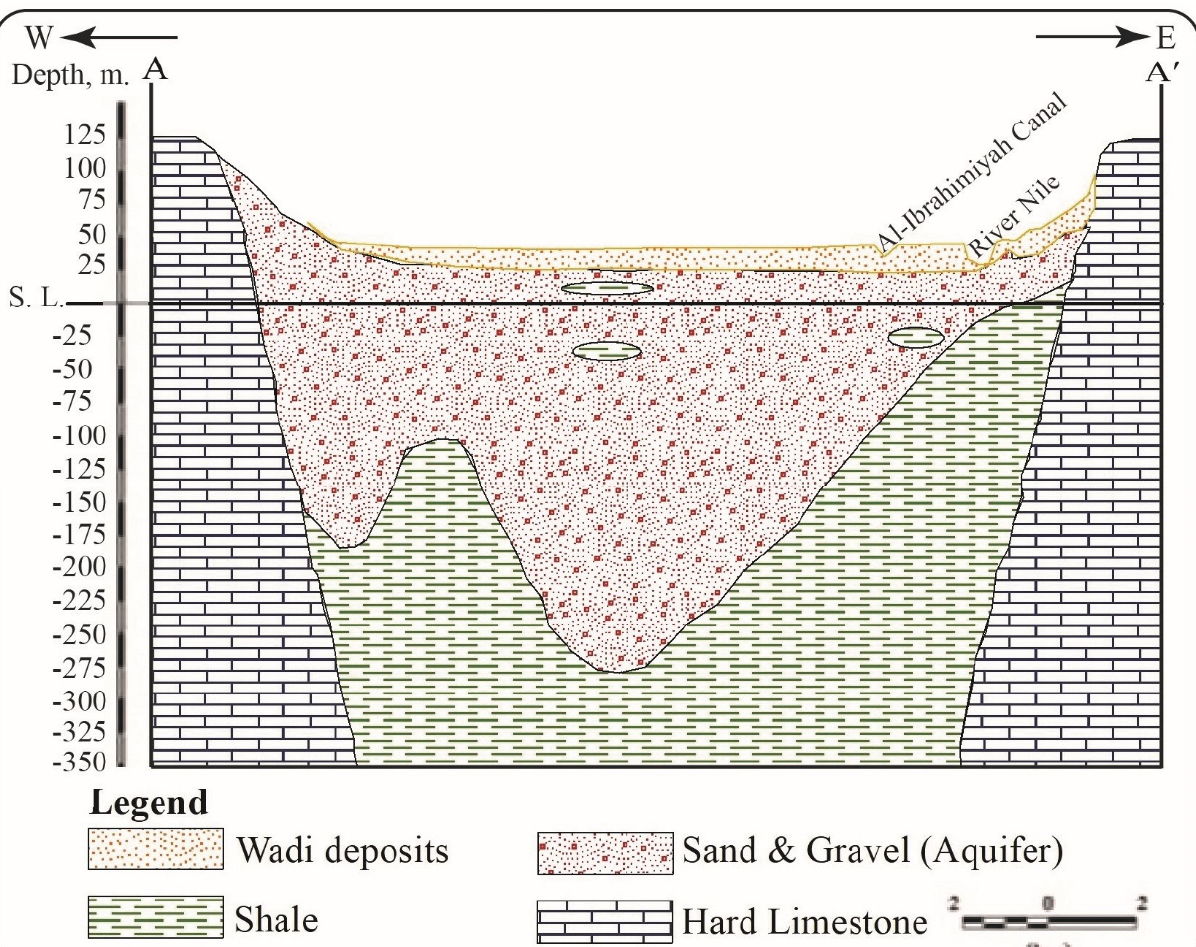
Figure 2. Geologic map of the study area (after [37]).